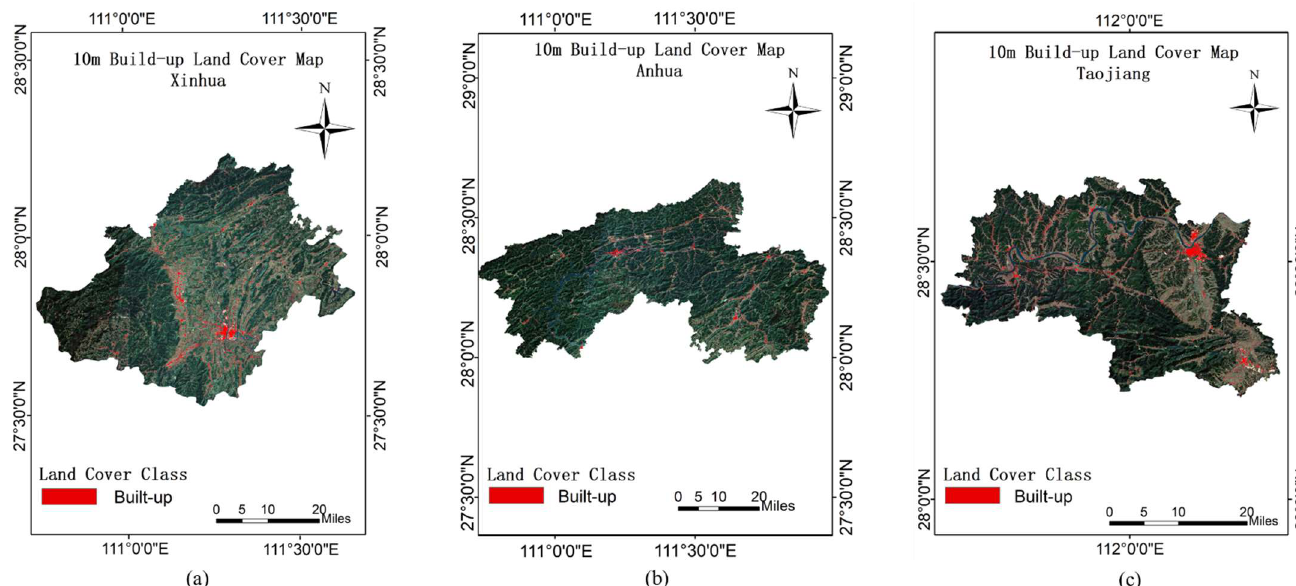
Figure 6. ( a ) The 10 m resolution build-up land mapping of Xinhua County. ( b ) The 10 m resolution build-up land mapping of Anhua County. ( c ) The 10 m resolution build-up land mapping of Taojiang County.